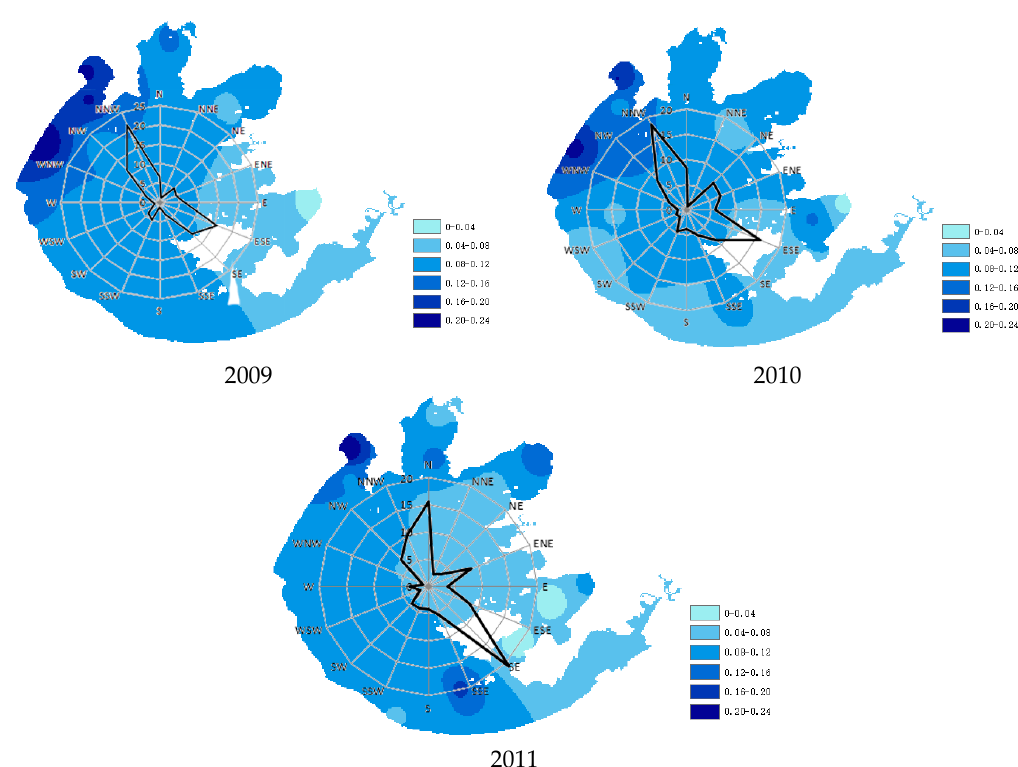
Figure 5. Map showing the spatial distribution of mean annual total phosphorus (TP) concentration (mg·L − 1 ), superimposed by the plot (signified by black line) of wind direction occurrence.